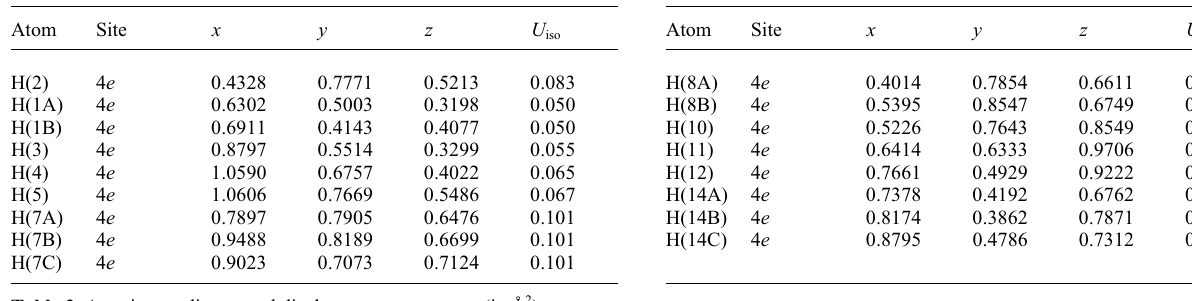
Table 2. Atomic coordinates and displacement parameters (in Å 2 )